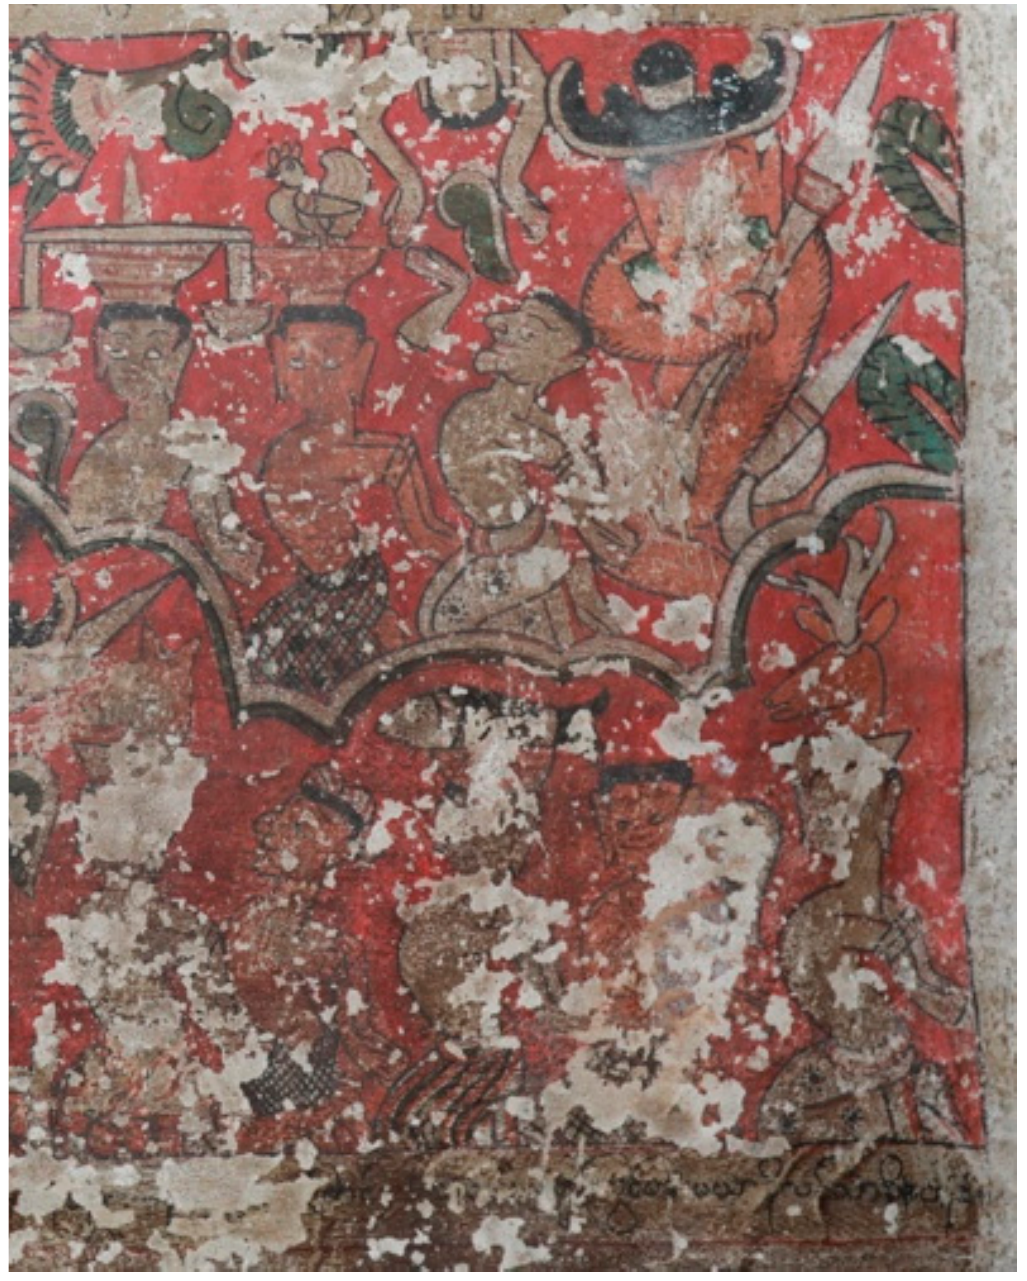
Figure 49. Anaint, 18th century. Punishments for transgressions, including mistreating animals.